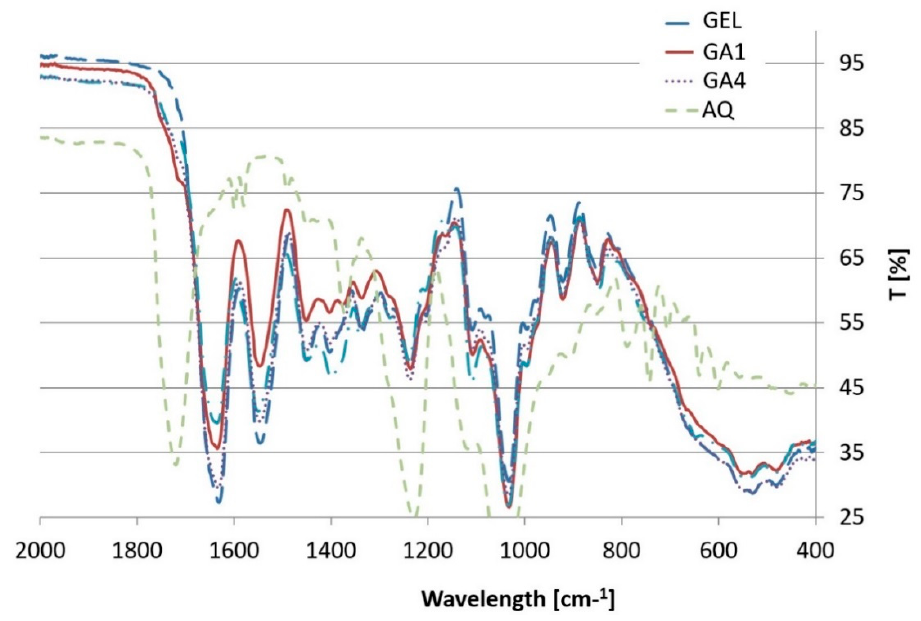
Figure 6. FTIR spectra of bovine ‐ gelatin based formulations (GEL, GA1, GA4,) and spectrum of the AQ film.